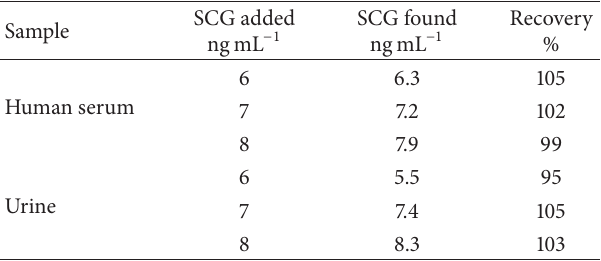
Table 3: Determination of SCG in synthetic